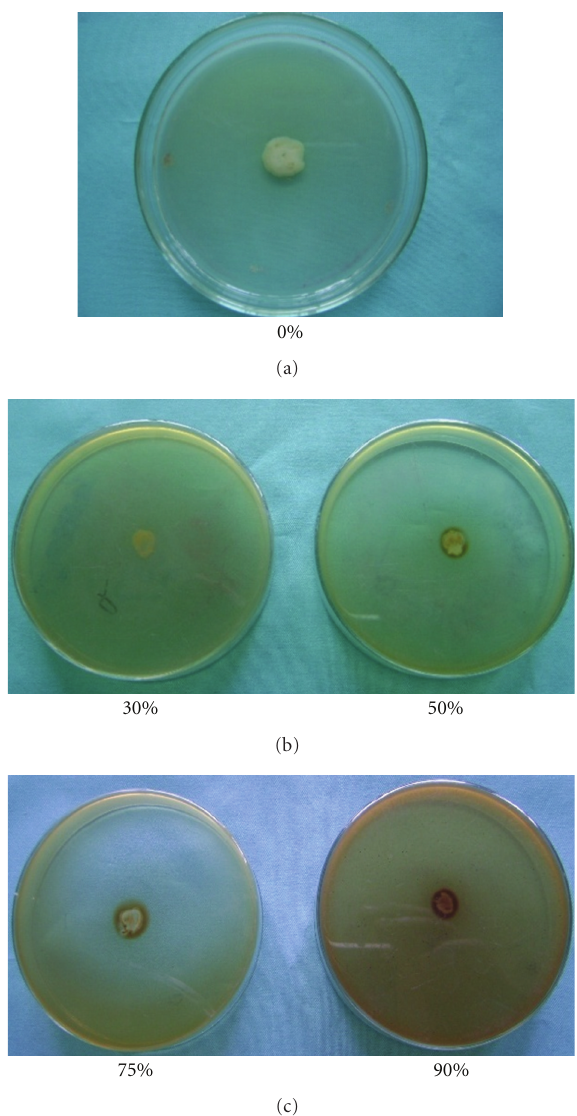
Figure 1: Antibacterial activity of jute leaf extract against Ecc P-138 at di ff erent concentrations of the extract in YPDA